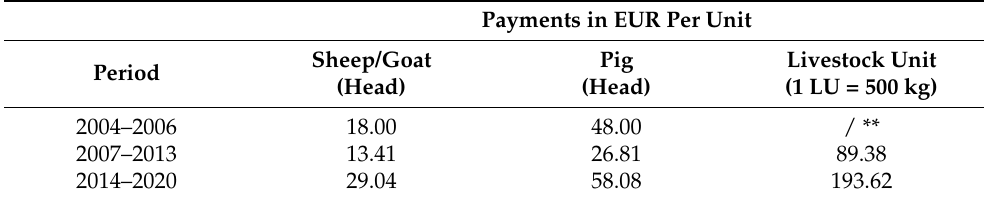
Table 1. Overview of monetary incentives for rearing the local breeds in Slovenia from 2004 to 2020